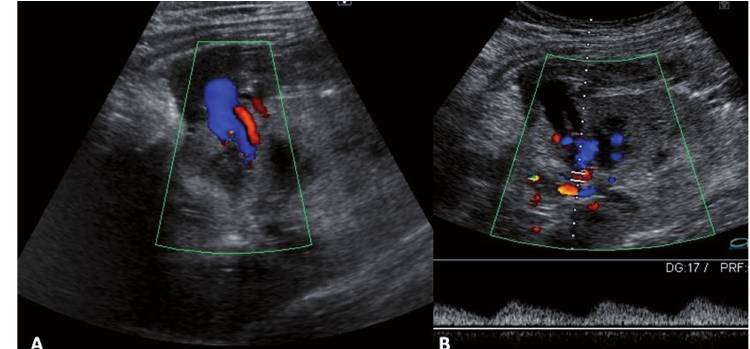
Figure 1 - a-Doppler ultrasound with reverse diastole in interlobular artery and lesion suggestive of pseudoaneurysm at the middle pole of the kidney. Cystic formation which implies the renal parenchyma toward the collection, that measured about 1.2cm.